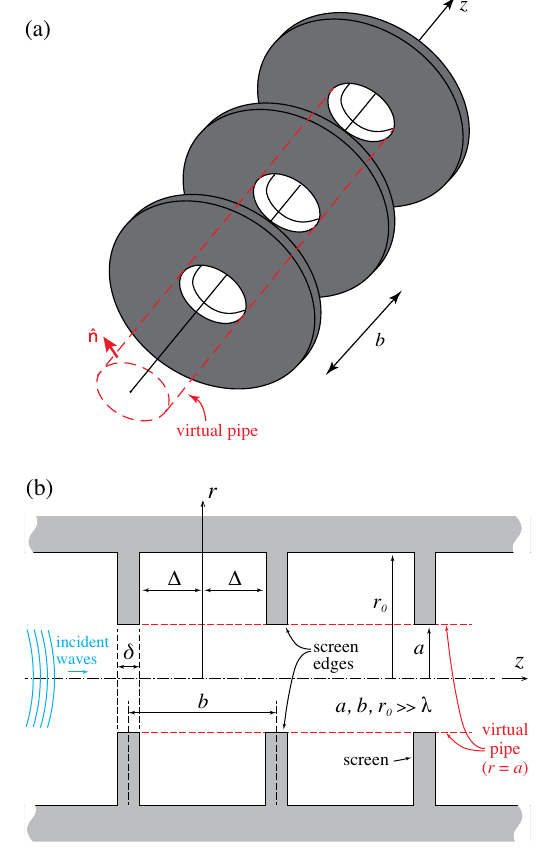
FIG. 1. (a) The iris-line geometry shown in three dimensions, without the enclosing chamber at the outer radius. (b) A cross section in the iris line, showing dimensions and labeling.